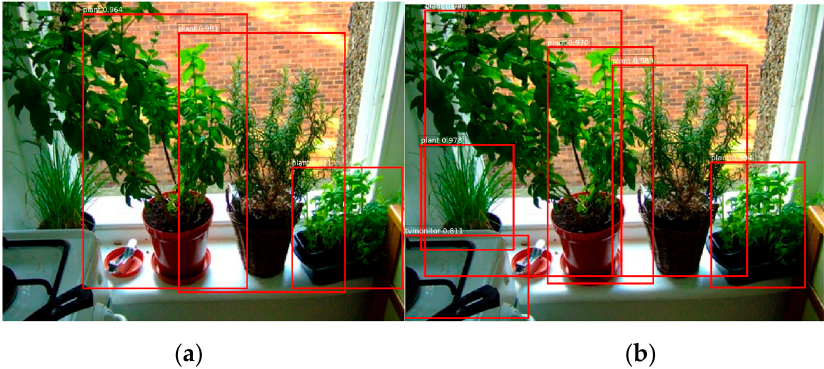
Figure 7. The detection results with scene-level information or without scene-level information. ( a ): without scene-level information. ( b ): with scene-level information.